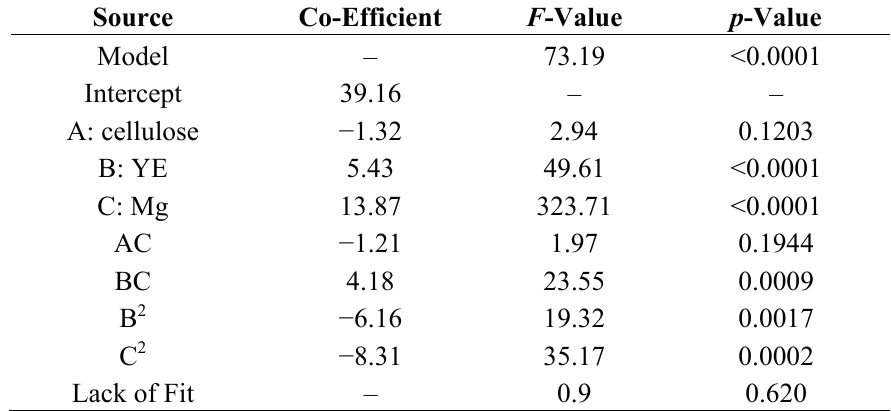
Table 7. Reduced quadratic model obtained for ethanol concentration. Model co-efficients are presented in terms of coded factors.